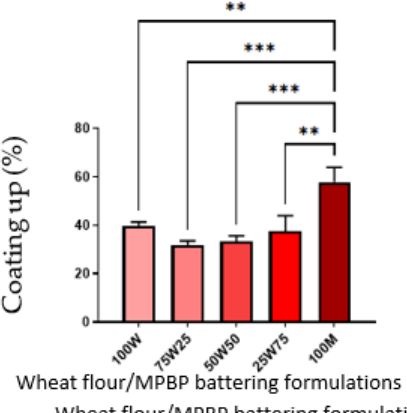
Figure 4. Coating of batter-coated shrimp with MPBP. 100 W: 100% wheat flour, 75 W25: 75% wheat flour and 25% MPBP, 50 W50: 50% wheat flour and 50% MPBP, 25 W75: 25% wheat flour and 75% MPBP, 100 M: 100. The error bars indicate standard division. ** p < 0.005, *** p < 0.0005.